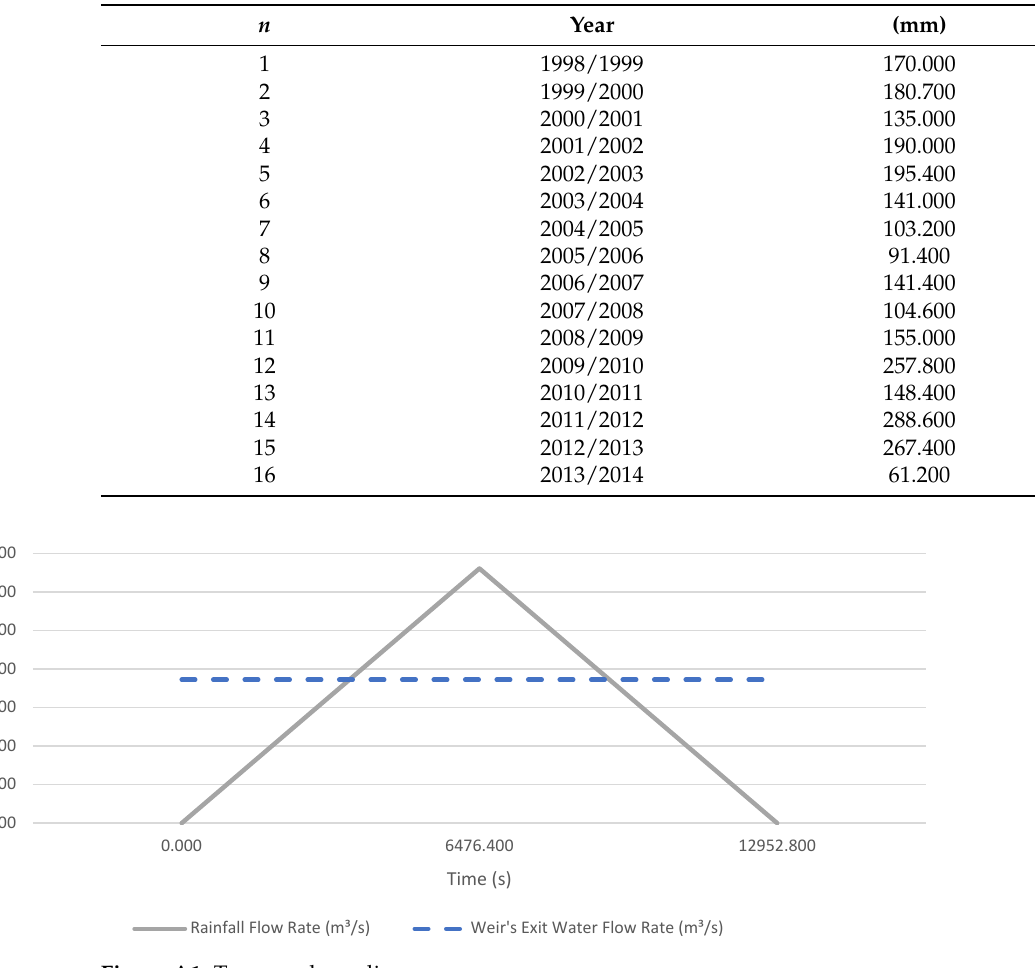
Figure A1. Ternary phase diagram.